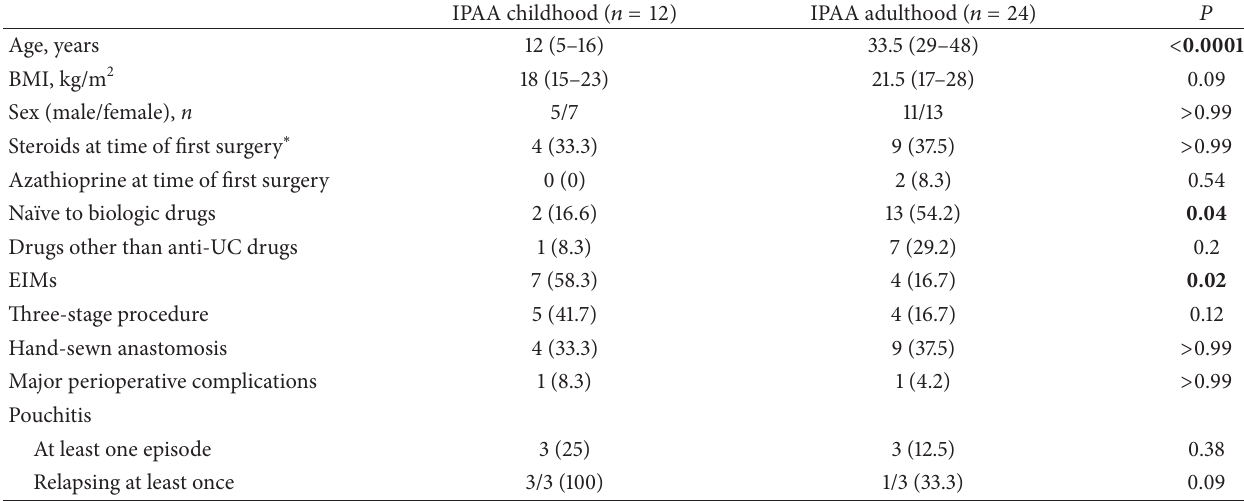
Table 1: Characteristics of IPAA patients by age. Except where indicated otherwise, data are median (range) or n (%) values.